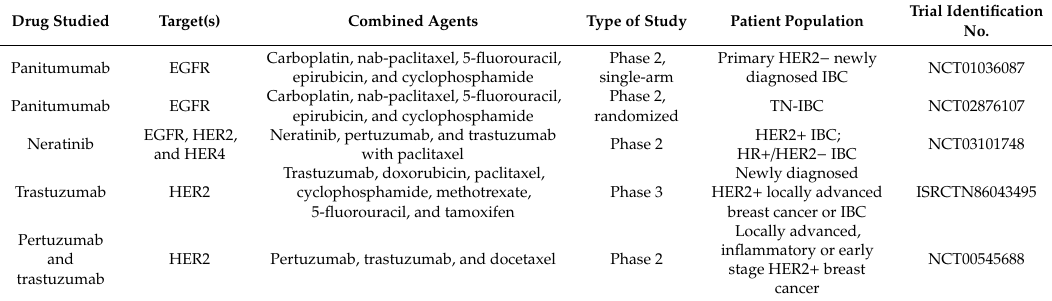
Table 1. Clinical trials in inflammatory breast